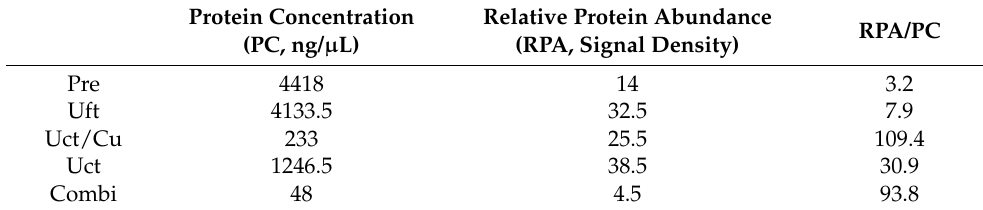
Table 2. Estimating purity of OMV